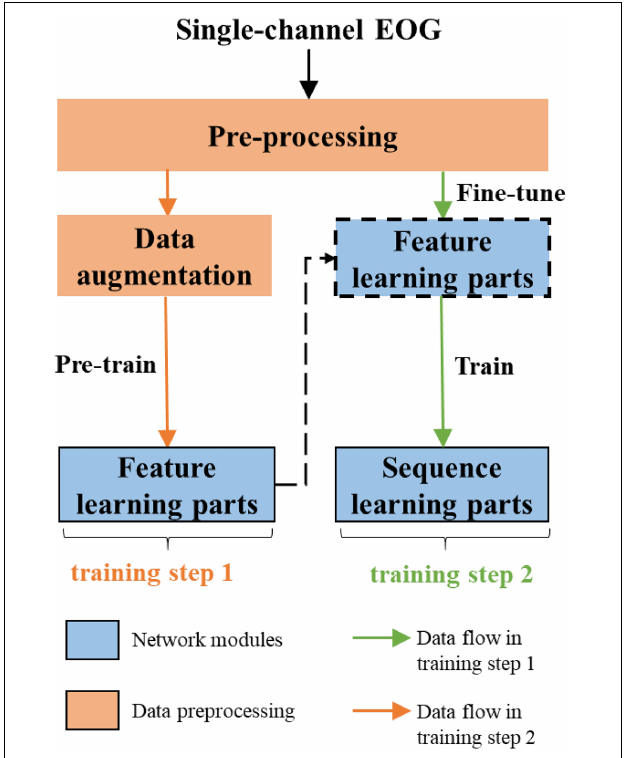
FIGURE 2 | The overall workflow of the proposed